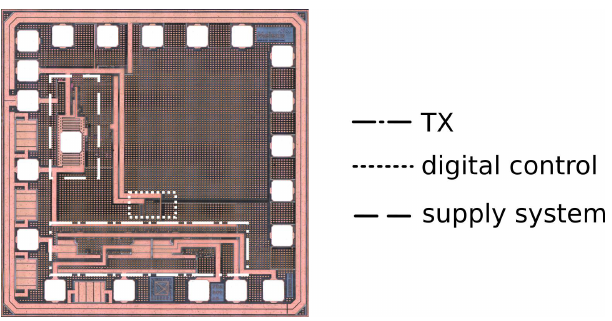
Figure 10. Test Chip 2000 × micrographs picture.